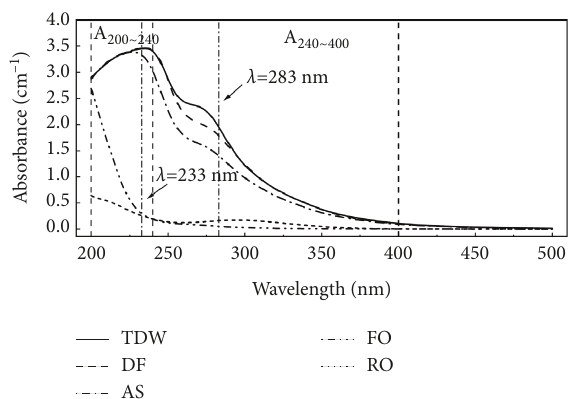
Figure 4: UV-vis spectra of the effluent from different processes.